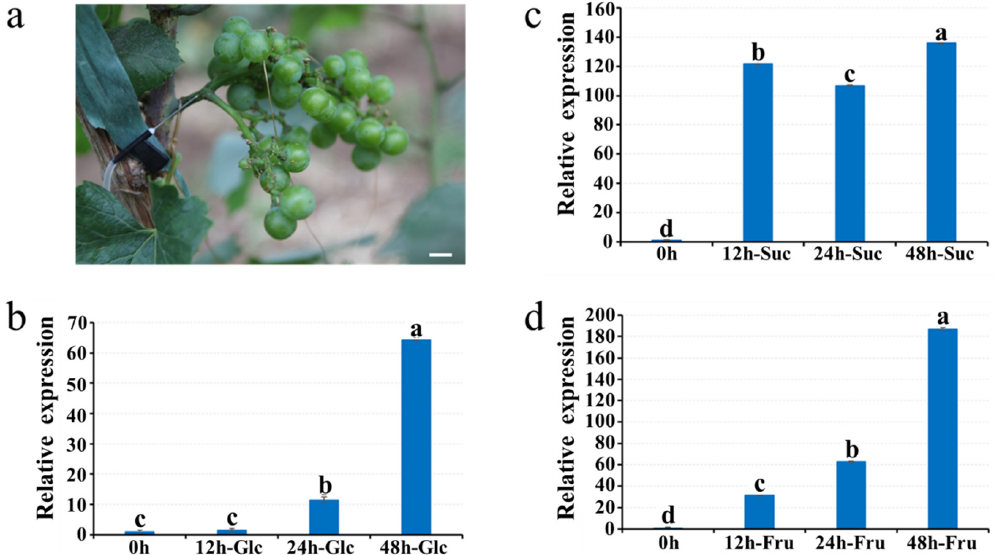
Figure 6. The relative expression profiles of VvGH9 in grape berry injected with sucrose ( a ), glucose ( b ), and fructose ( c ) and treatment of ‘Chardonnay’ grape berry before v é raison with exogenous sugars via injection ( d ). Scale bars, 1 cm. The letters above the bars indicated the significant differences by student’s t -test ( p < 0.05). Three biological replicates were analyzed, and the error bars represented the SD.